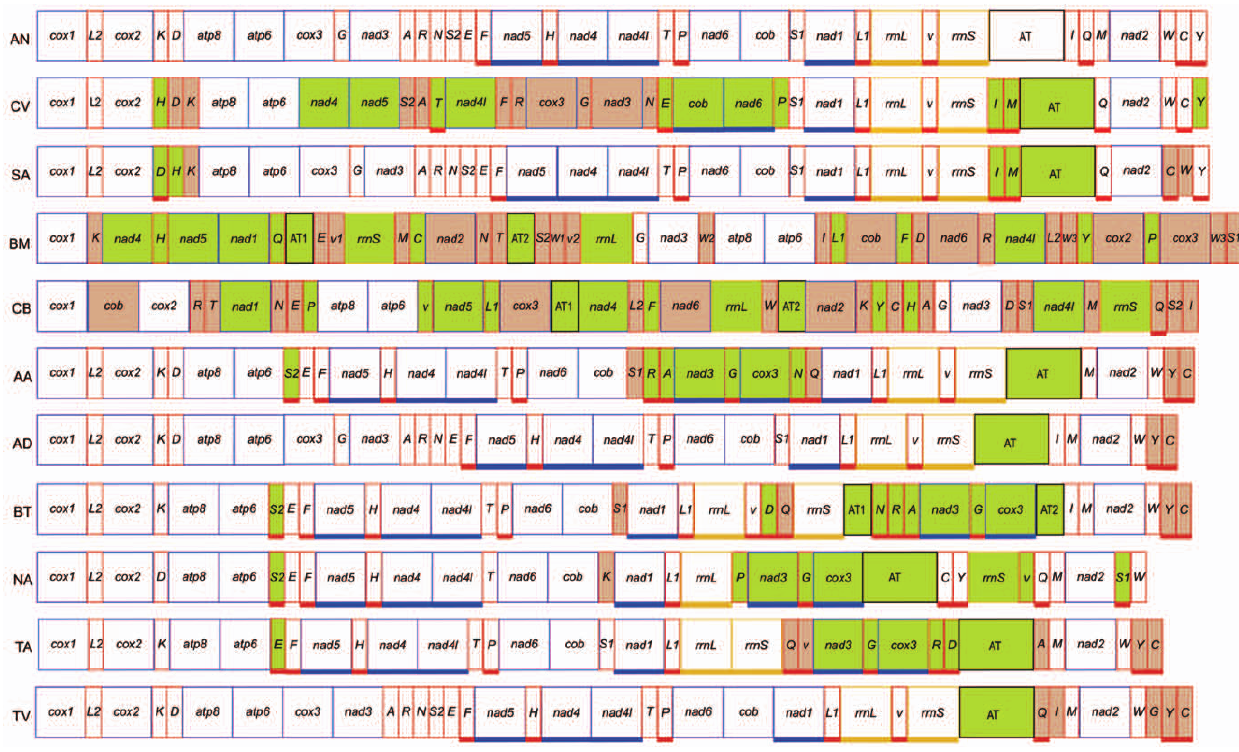
Figure 3. Gene arrangement of the mitochondrial genome of 10 species with reversal of strand asymmetry. Genes are showed in boxes. Box with underscore indicates that the gene is encoded on minority strand while box without underscore indicates that the gene is encoded on majority strand. Rearranged genes compared to the ancestral mitochondrial genome arrangement were marked with colours. Green indicates that the gene was inverted or remotely inverted, while brown indicates that the gene was translocated or shuffled. AT indicates the A + T-rich region. A + T- rich regions of all species were inverted and marked in green. AN: Ancestral arrangement; CV: Cotesia vestalis ; SA: Spathius agrili ; BM: Bothriometopus macrocnemis ; CB: Campanulotes bidentatus ; AA: Aleurochiton aceris ; AD: Aleurodicus dugesii ; BT: Bemisia tabaci ; NA: Neomaskellia andropogonis ; TA: Tetraleurodes acacia ; TV: Trialeurodes vaporariorum . four-fold redundant third codon positions for individual protein- coding genes (Figure 4, Figure S1 and Table S1).